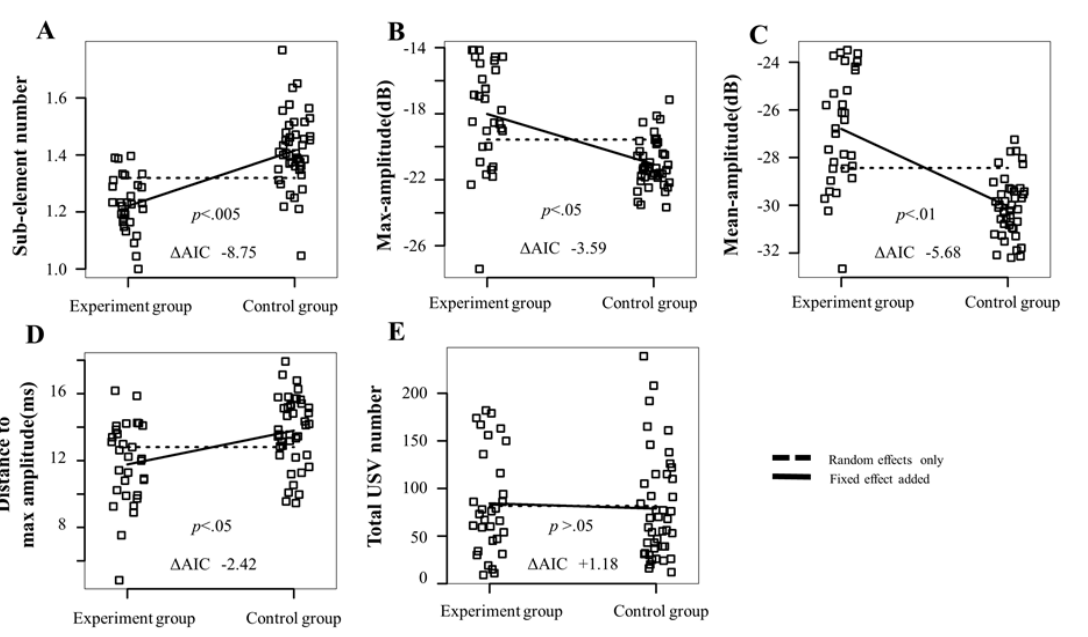
Figure 3 . Difference in USV acoustic parameters between groups. A) Sub-element number. B) Max-amplitude. C) Mean- amplitude. D) Distance from start to max. E) Total USVs number. Each open square represents the averaged feature value for each day and each individual. Dashed lines represent the predicted value by the model that consisted of random effects (the length of the waiting phase and individual differences) and an intercept. Solid lines represent the predicted value when a fixed effect (Experiment group) was added to the above model and with a slope and an intercept. The magnitude of the slope of the solid line is equal to the value of the fixed effect to each acoustic parameter. A Gaussian distribution was used as the error structure. The ΔAIC is the difference between the model AIC that contained only the random effects and the model that added the fixed effect to the random